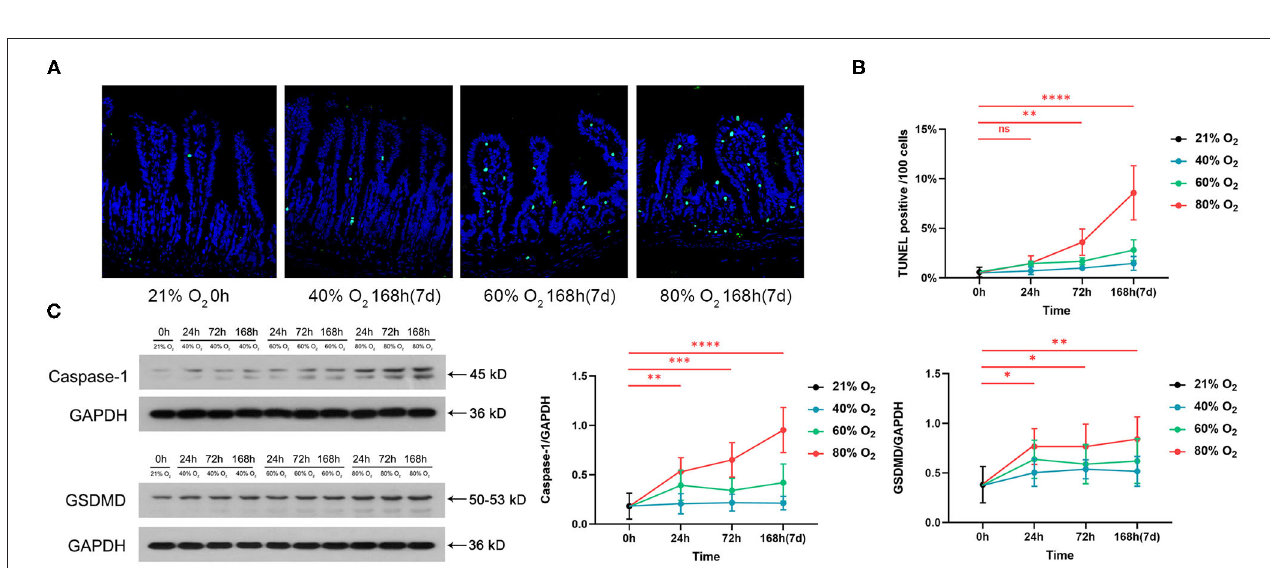
FIGURE 1 | gut mucosal framework with intact and well-defined villi. There was remarkable intestinal mucosal atrophy in the oxygen groups (FiO 2 of 60 and 80%) which was featured by villus shortening and intestinal epithelial cell (IEC) degeneration with nucleus shrinkage and pink cytoplasm (black arrows). (C) Representative intestinal sections showing inflammatory cell infiltration from the control group and the oxygen groups (FiO 2 of 40, 60, and 80%) were exposed for 168h (7 days) at high magnification (400 × ). There are more infiltration of polymorphonuclear leucocytes (neutrophils, black arrows) and macrophages (red arrows) in the IEC in the oxygen groups vs. the control group. There are less paneth cells (blue arrows) filled with eosinophilic particles at the base of small intestinal crypts in the oxygen groups vs. the control group. (D) The graph of the villus height in the control and the oxygen groups. (E) The graph of the crept depth in the control and the oxygen groups. (F) The graph of the intestinal injury scores in the control and the oxygen groups. * P < 0.05; ** P < 0.01; *** P < 0.001; **** P < 0.0001 ( P -values: 80% of oxygen group vs. the control group).